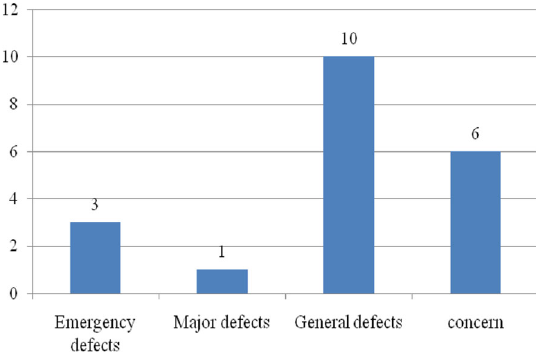
Fig. 8 Results of tree barrier modeling in case study. The numbers of emergency defects, major defects, general defects and concerns are 3, 1, 10 and 6,